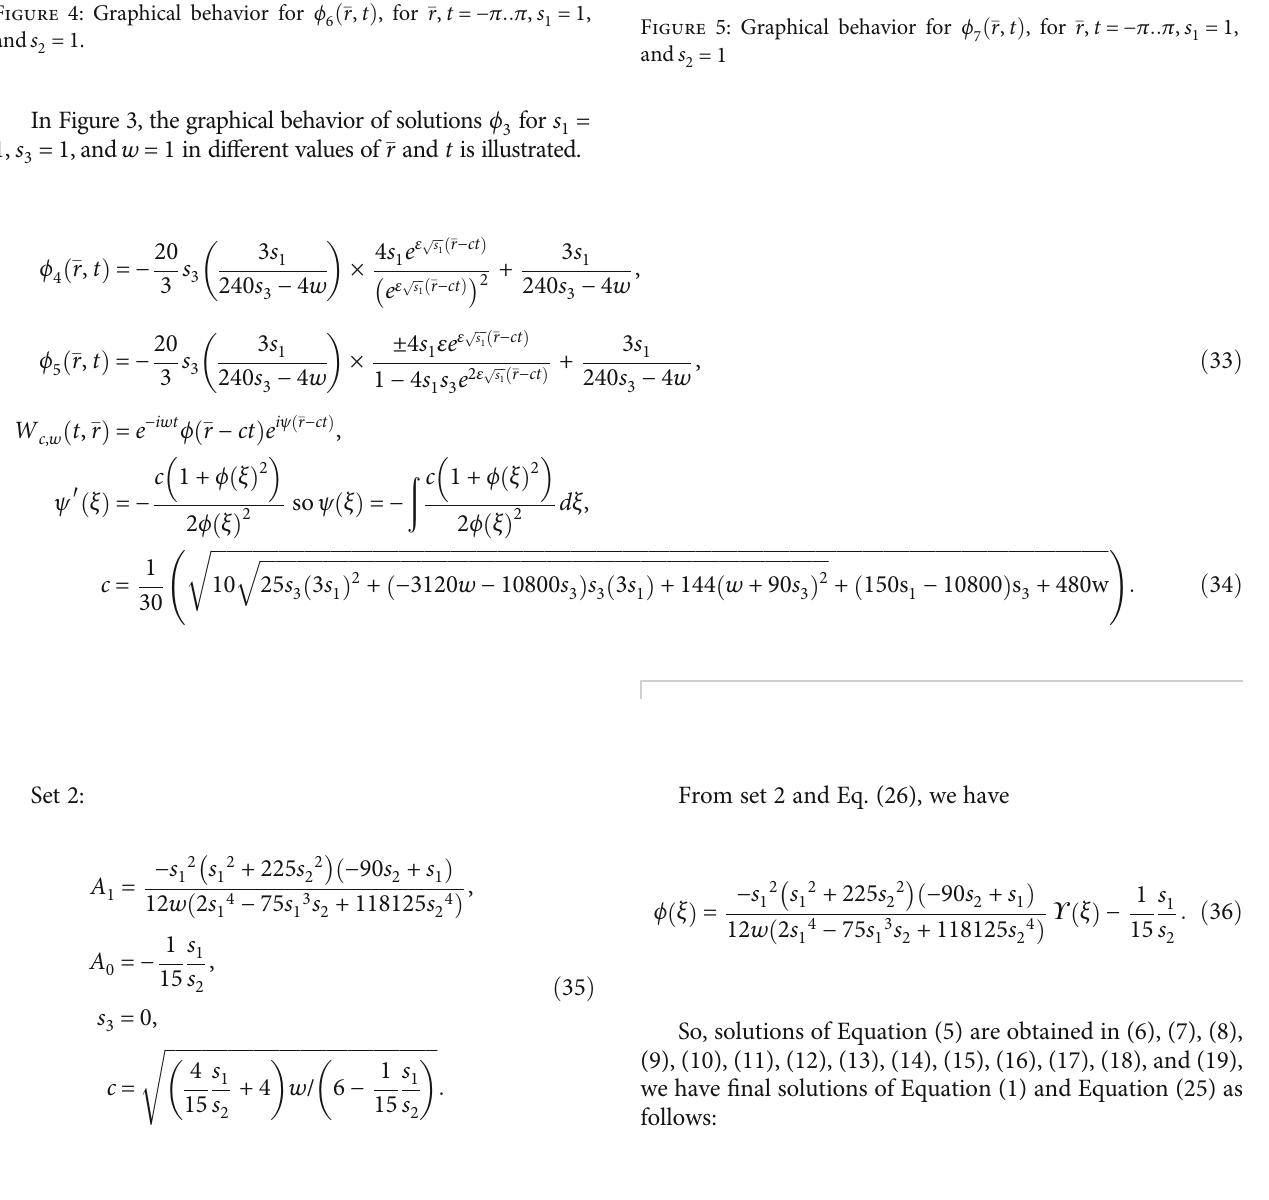
ð (cid:1) r , t Þ , for (cid:1) r , t = − π :: π , s 6